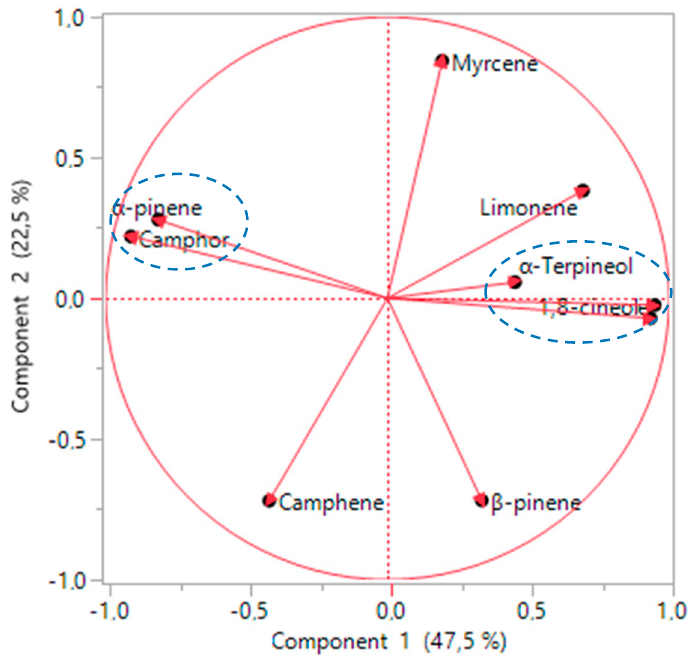
Figure 2. Loading plot that presents the cloud of variables in the first and second principal compo- nents.